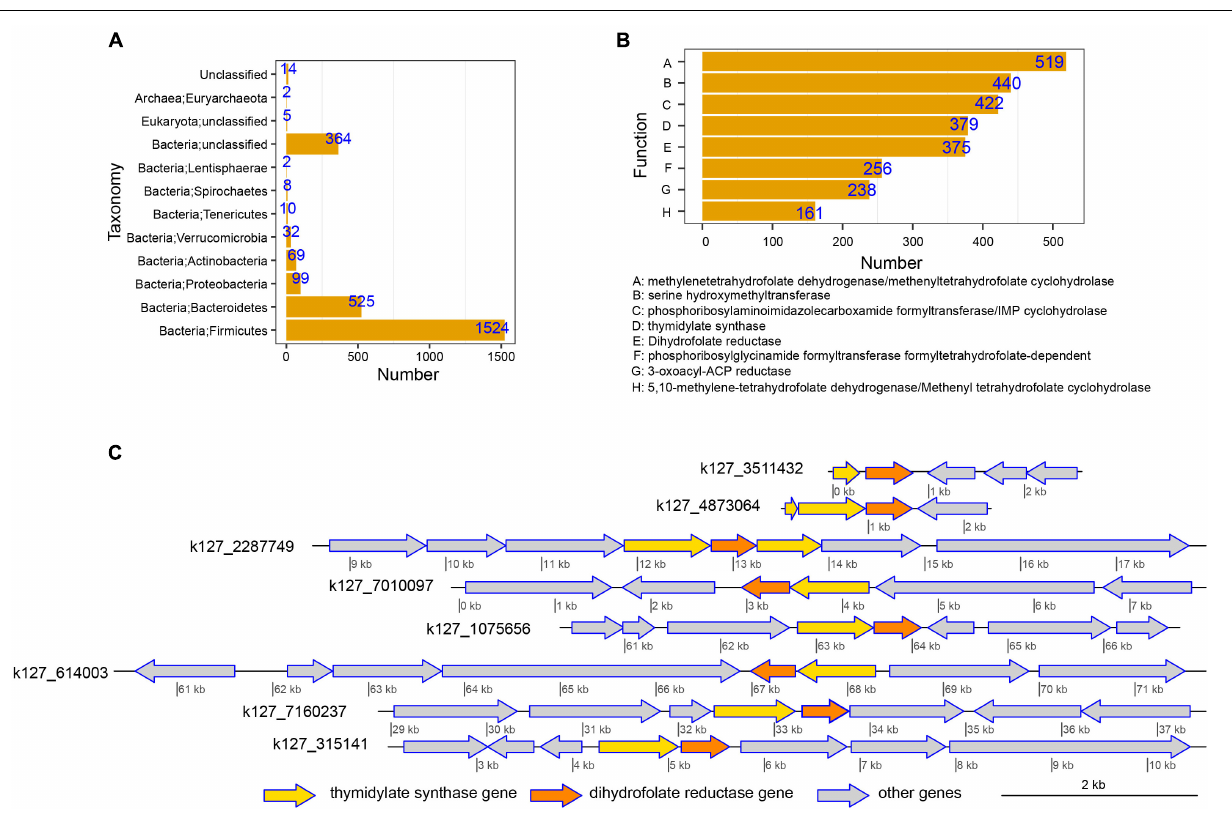
FIGURE 4 | Host-tracking, functional annotation, and physical distribution of genes involved in methotrexate (MTX) metabolism were explored to obtain an in-depth understanding of the interactions between drug response and gut microbiota. (A) Taxonomical distribution of genes involved in MTX metabolism. The results suggest that Firmicutes and Bacteroidetes were the dominant hosts of the genes involved in MTX metabolism and had the potential to metabolize MTX in the intestinal tract. (B) Distribution of functional traits for genes involved in MTX metabolism. (C) Occurrences of the thymidylate synthase gene and dihydrofolate reductase gene in different assembled contigs were used as an example to reveal the complex and diverse distributions of genes involved in MTX